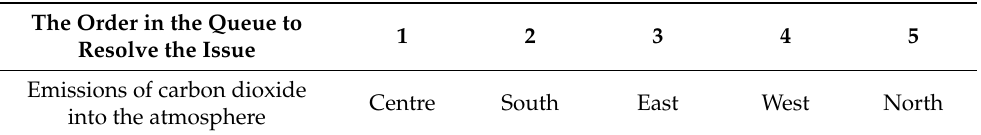
Table 1. Priority of solving problems of anthropogenic factor of CO 2 emissions into the atmosphere by region of